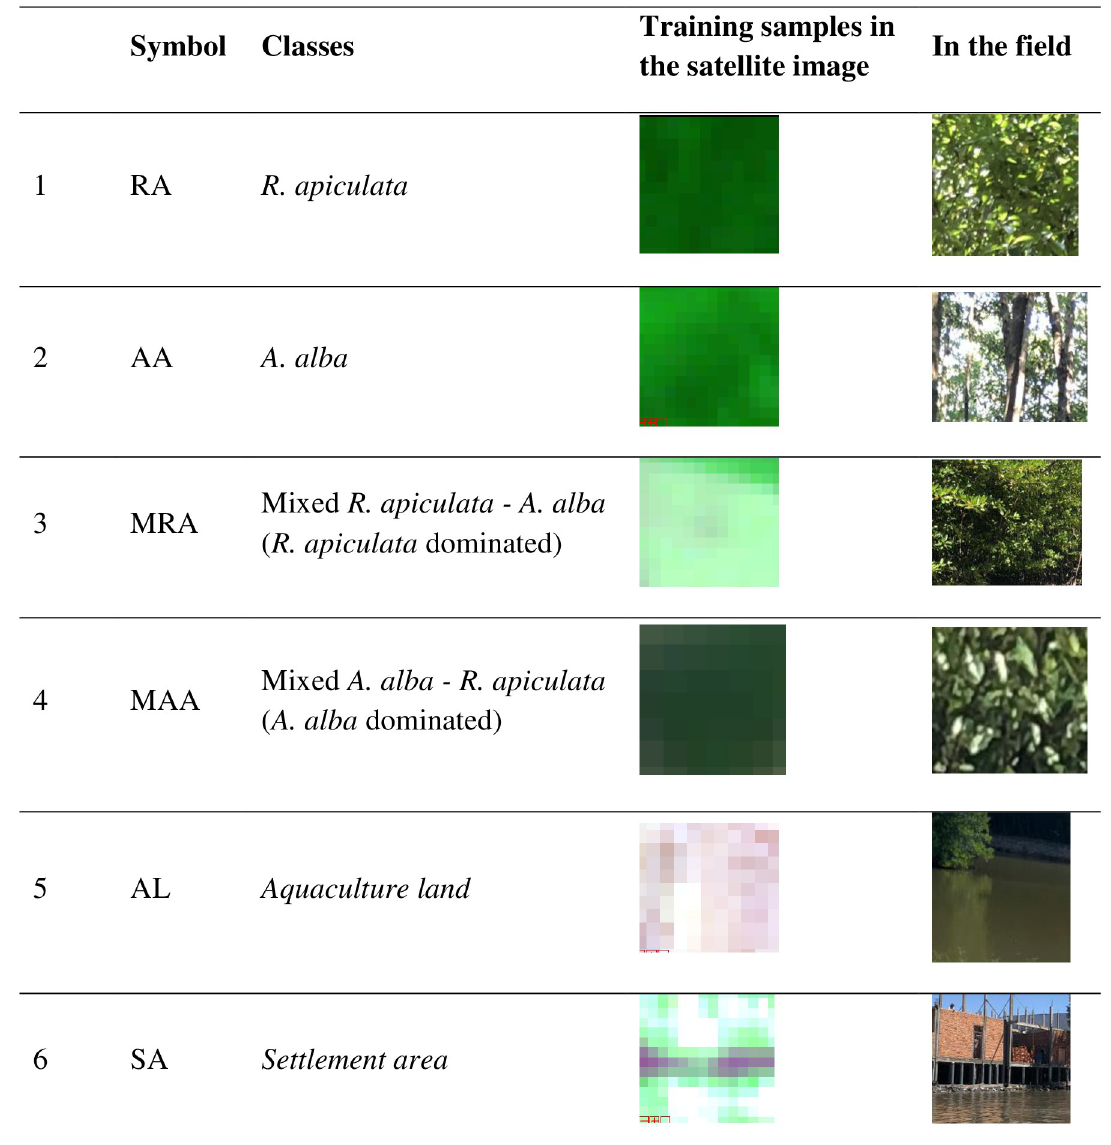
Fig 4. The illustrations of some training samples for the satellite image